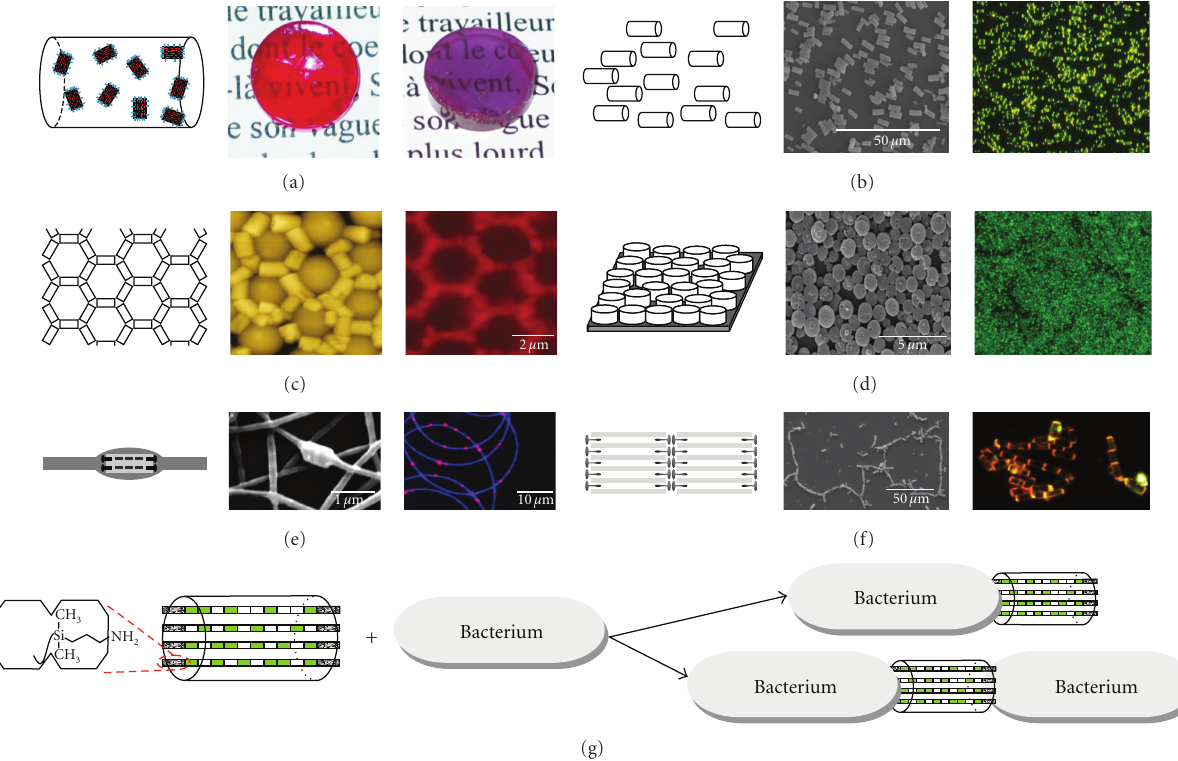
Figure 4: Summary of materials obtained by supramolecular organizations of zeolite L crystals. (a) Randomly oriented zeolite L crystals in a polymer. Photographic images of zeolite L-polymer hybrid materials prepared from crystals loaded with either red or violet dyes (Hostasol Red GG or Ox + , resp.) [48, 49]. (b) Nematic phase arrangement. Left: SEM and fluorescence microscopy image of Py + -zeolite L crystals aligned in a stretched PVC plastic film [77]. (c) Hexagonal arrangement. The dye-zeolite L crystals are organized by a surface-tension-driven self-assembly process on a PDMS/PS film (SEM and fluorescence microscopy image are shown) [78]. (d) Monolayers of standing zeolite L crystals. Left: SEM image of a monolayer. Right: fluorescence microscopy image of a monolayer loaded with Py [45–47]. (e) Nanofibers with embedded zeolite L. Left: SEM image of nanofiber with embedded zeolite L crystals. The crystals are oriented along the fiber axis. Right: Fluorescence image of a PEO/DDT nanofiber (blue emission) with embedded Ox-zeolite crystals (red sparks) [79]. (f) Chain-like assemblies of zeolite L crystals. Right: SEM image of zeolite crystals linked together by modifying the channel entrances with a cationic stopcock (D291) and corresponding fluorescence microscopy image [77]. (g) Assembly of zeolite L/bacterium in PBS bu ff er solution and self-assembly of two bacteria with functionalized 1- μ m zeolite L as the junction